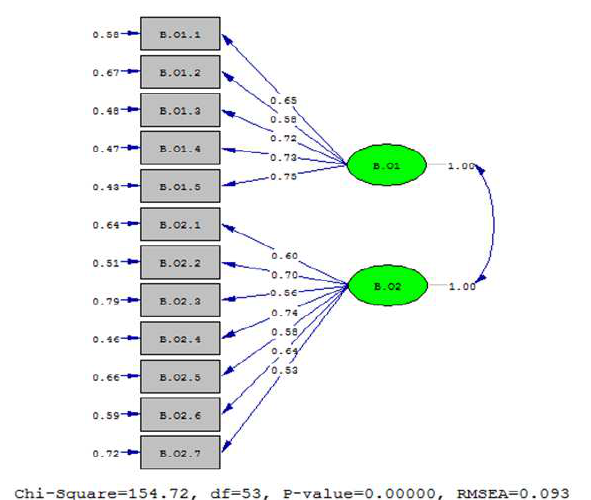
Fig. 3. Confirmatory factor analysis for change readiness